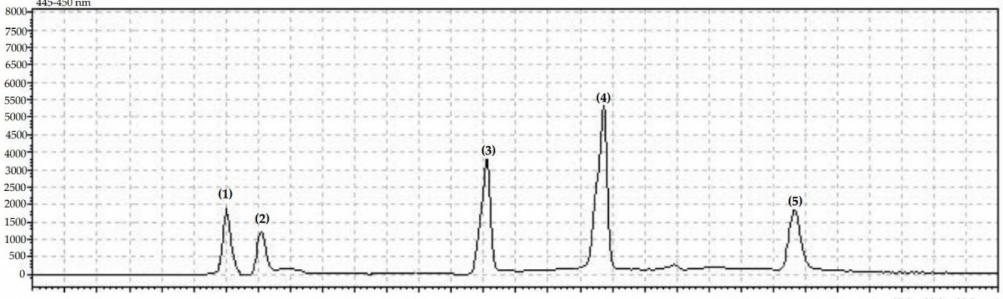
Figure 1. Chromatogram showing retention times for identified carotenoids and chlorophylles: ( 1 ) lutein, ( 2 ) zeaxanthin, ( 3 ) chlorphyll b, ( 4 ) chlorophyll a, ( 5 )